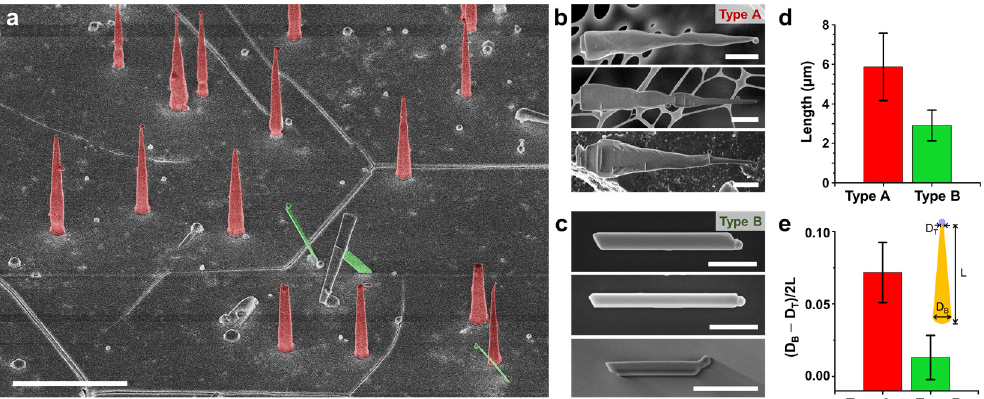
Figure 1. Sn-assisted, vapor-liquid-solid (VLS)-grown PbI 2 nanowires on the [0001]-oriented c-sapphire substrate. ( a ) 45 ◦ view SEM image of PbI 2 nanowires exhibiting two distinct morphologies: tapered, vertical nanowires (false-colored in red), and ribbon-like, tilted nanowires (false-colored in green). Scale bar, 5 μ m. SEM image gallery of ( b ) vertical nanowires (denoted by type A) transferred onto a lacey carbon TEM grid, ( c ) kinked nanowires (denoted by type B) transferred to a Si wafer. Scale bars in ( b ) and ( c ), 1 μ m. ( d ) Comparison of the nanowire lengths of type A and B, grown for 15 min. Average values are 5.87 μ m and 2.90 μ m for type A and B, respectively. ( e ) Difference between type A and B in the degree of tapering, defined as the difference in the radius of top and bottom divided by the nanowire length. D B and D T denote the bottom and top diameters,